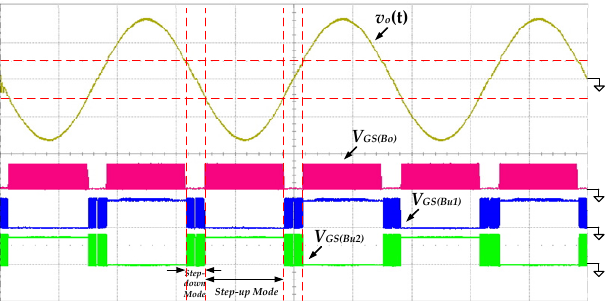
Figure 12. The measured waveforms of the gate-driving signals at 100 V input voltage and 500 W output load ( v o ( t ): 200 V/div; V GS ( Bo ) , V GS ( Bu 1) , V GS ( Bu 2) : 20 V/div; time: 5 ms/div).